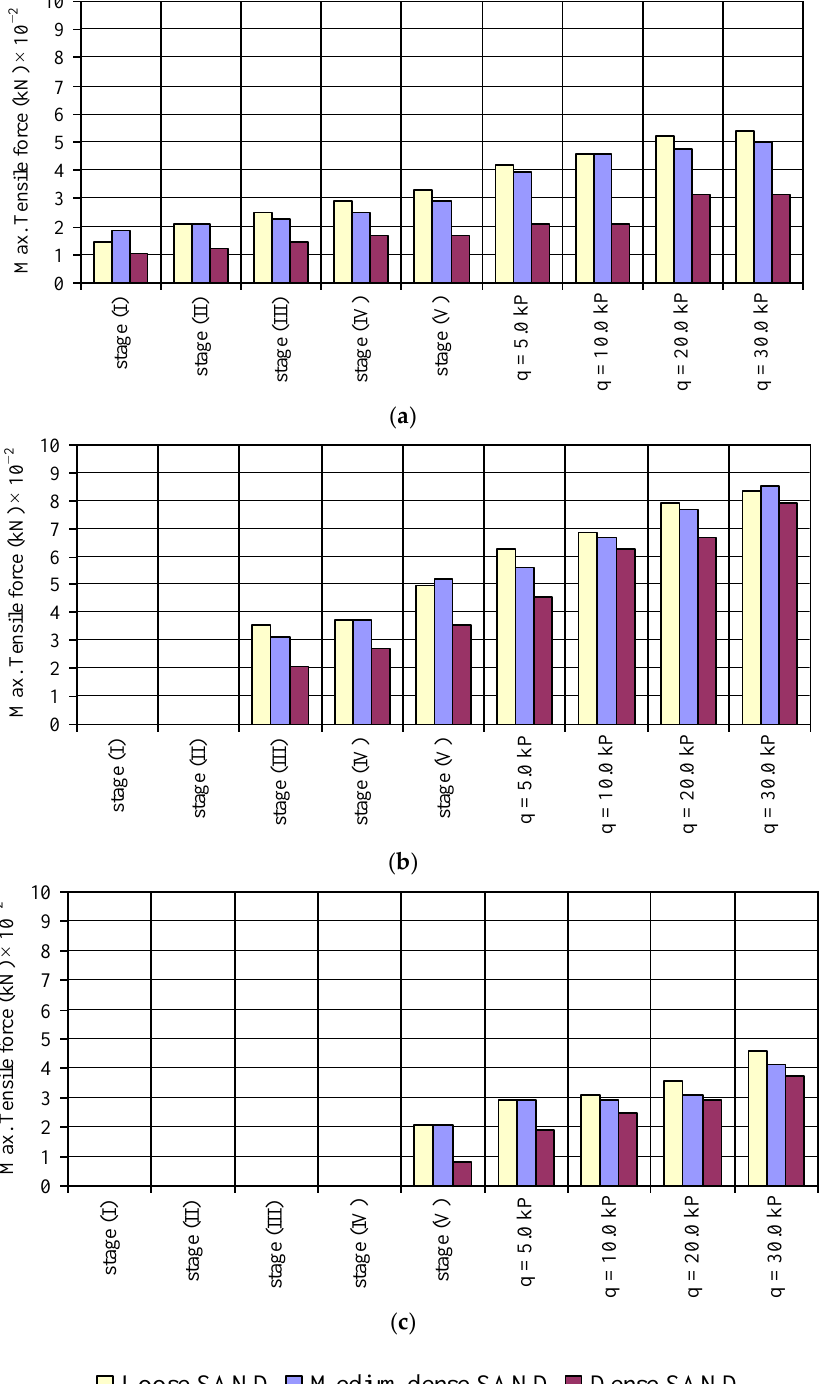
Figure 7. Influence of soil density on the maximum tensile force in the nails; ( a ) upper nail; ( b ) middle nail; ( c ) lower nail.